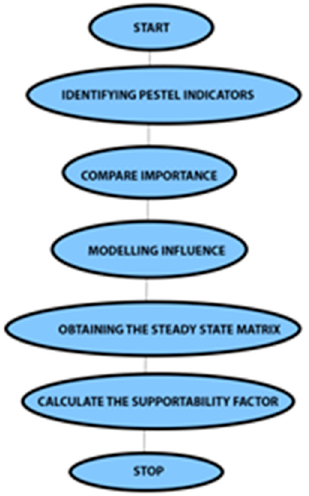
Figure 3. The framework for conducting a PESTEL (Political, Economic, Socio-cultural, Technological, Environmental, and + Legal) analysis